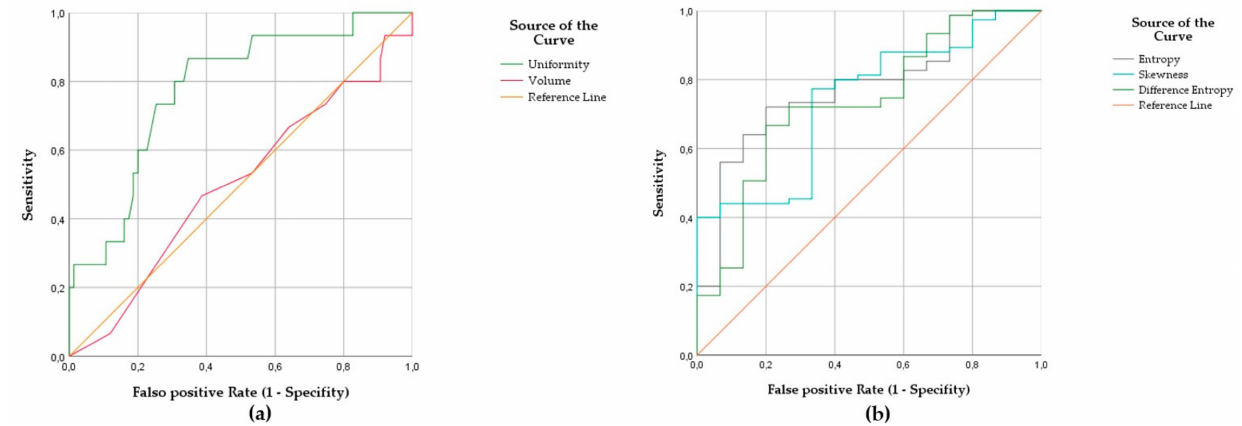
Figure 3. The receiver operating characteristics (ROC) curve of the feature “Uniformity” yielded an area under the curve (AUC) of 0.778, whereas “Volume” yielded an AUC of 0.500 for classification performance of CR and RD ( a ); ROC curves of the features “Entropy” (AUC 0.777), “Skewness” (AUC 0.738), and “Difference Entropy” (AUC 0.734) ( b